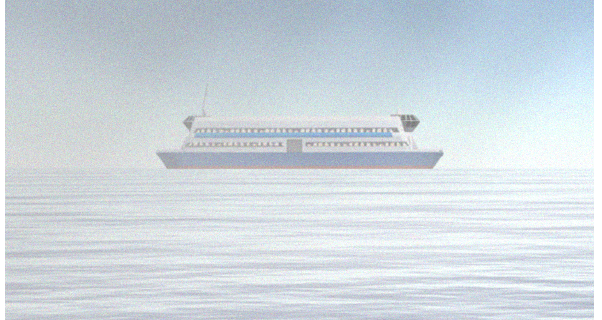
Figure 6. Example of an augmented synthetic image used for training the classification module. This image includes Gaussian noise and